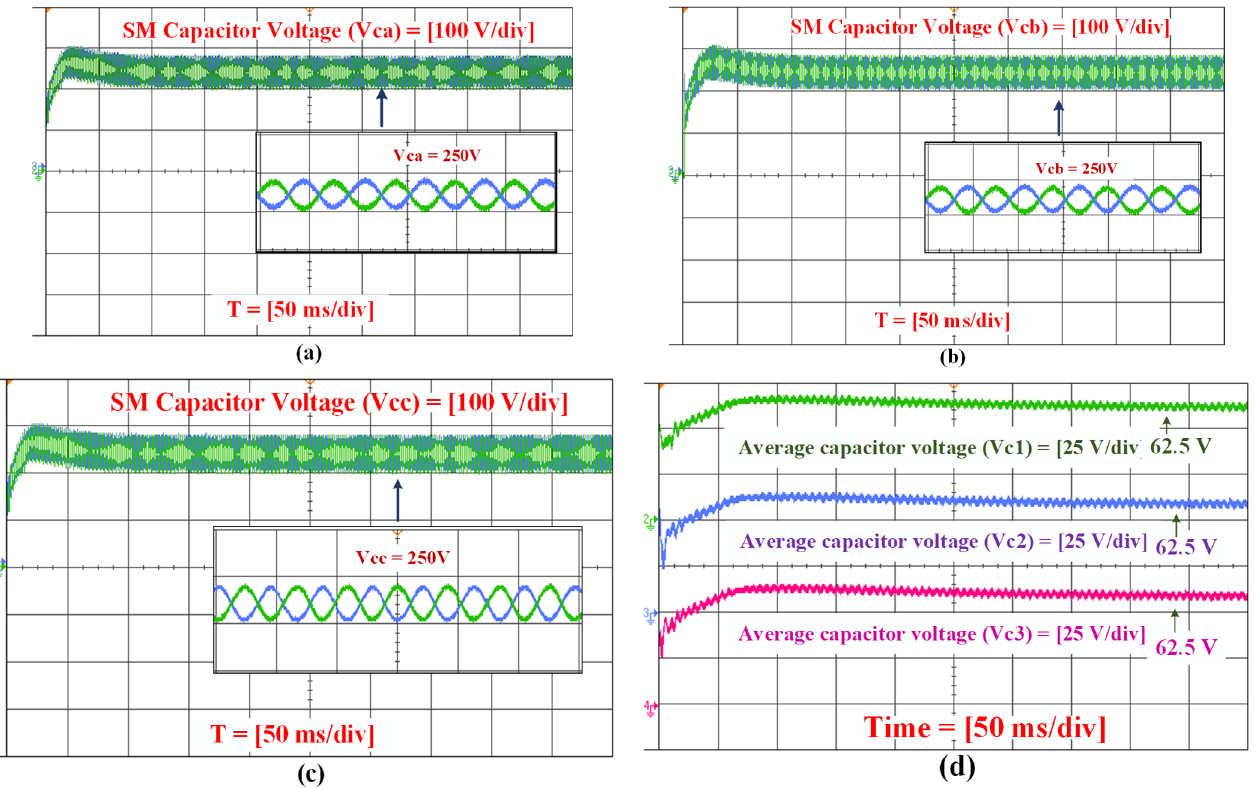
Figure 17. ( a ) Individual SM capacitor voltage (cid:1848) (cid:3030)(cid:3028) for each phase, ( b ) individual SM capacitor volt- age (cid:1848) (cid:3030)(cid:3029) for each phase, ( c ) individual SM capacitor voltage (cid:1848) (cid:3030)(cid:3030) for each phase, and ( d ) average SM capacitor voltage (cid:1848) (cid:3030)(cid:2869) ,(cid:1848) (cid:3030)(cid:2870) , (cid:1848) (cid:3030)(cid:2871) for each phase. capacitor voltage V c 1 , V c 2 , V c 3 for each